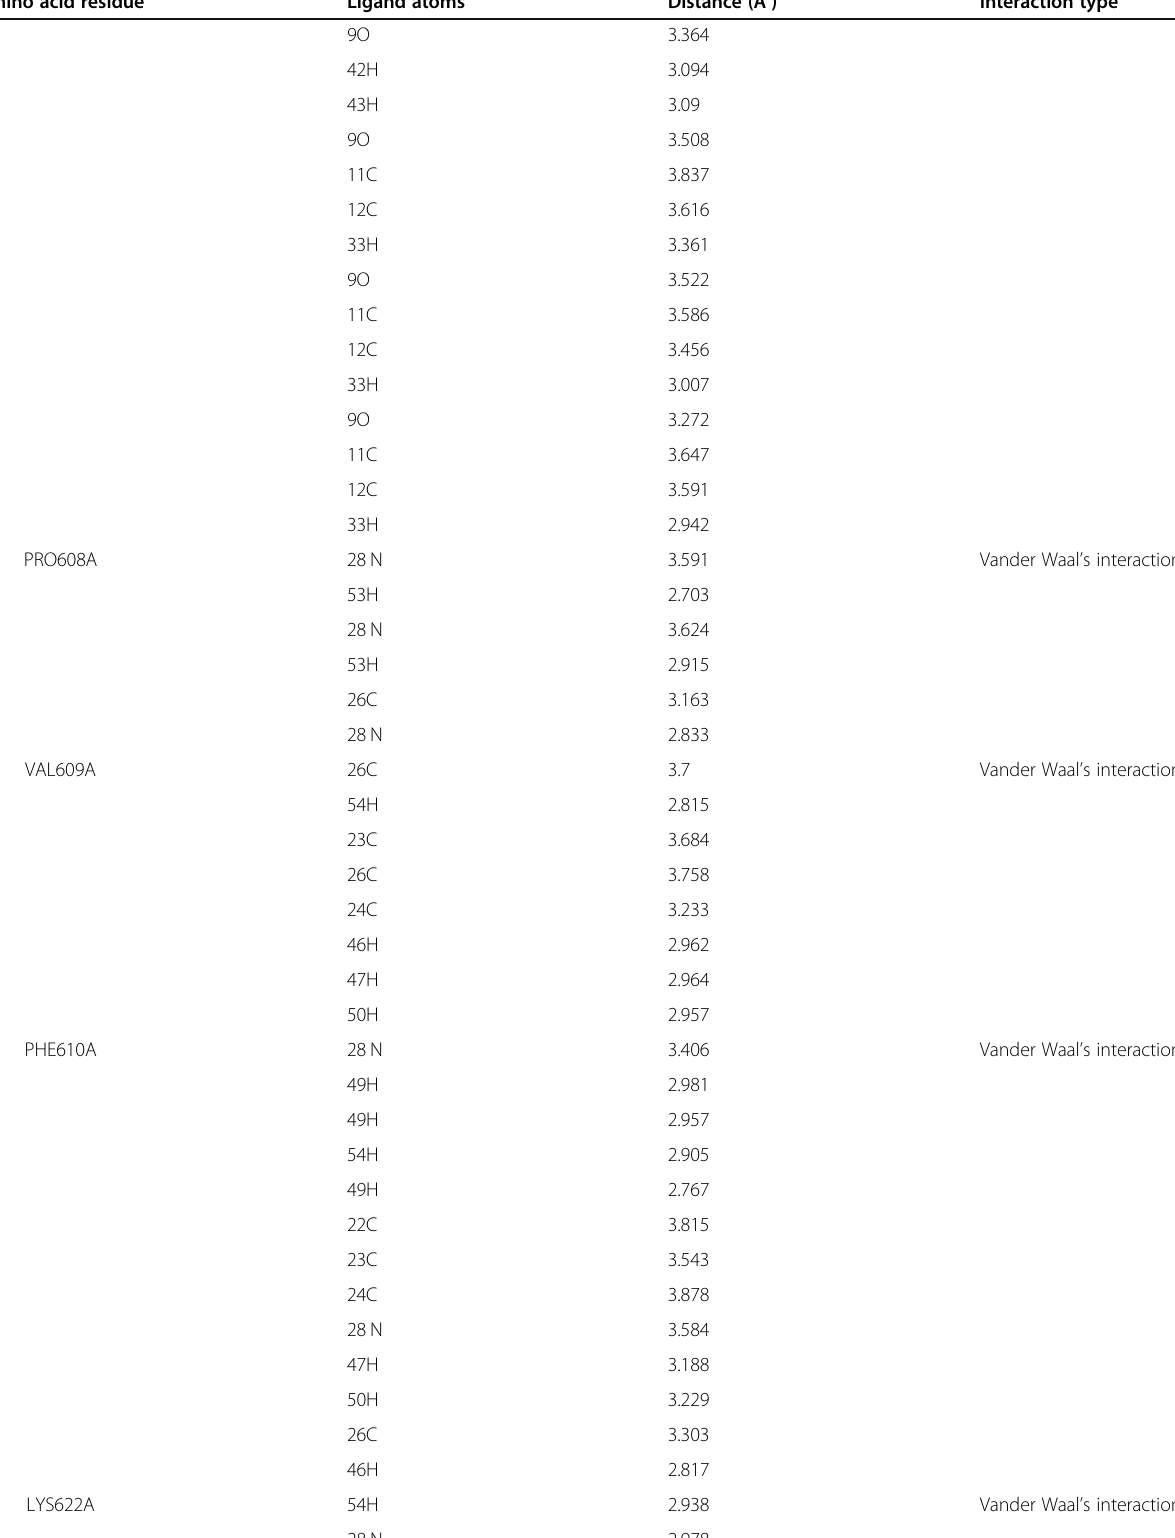
Table 5 Docking interaction of compound 51 with the binding pocket of 1S6Q (Continued) Amino acid